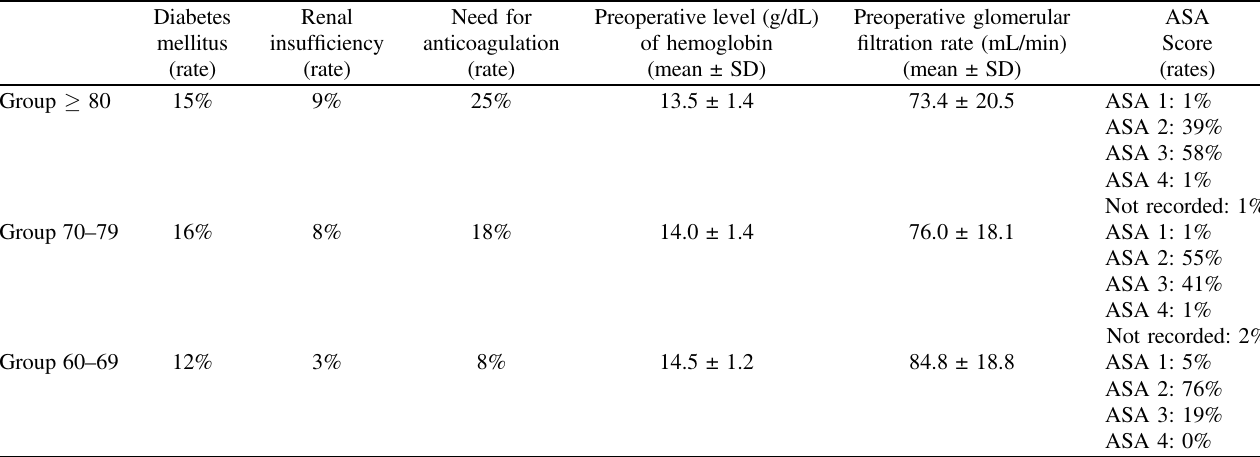
Table 2. Rate of medical comorbidities. Preoperative levels of hemoglobin and glomerular fi ltration rate.